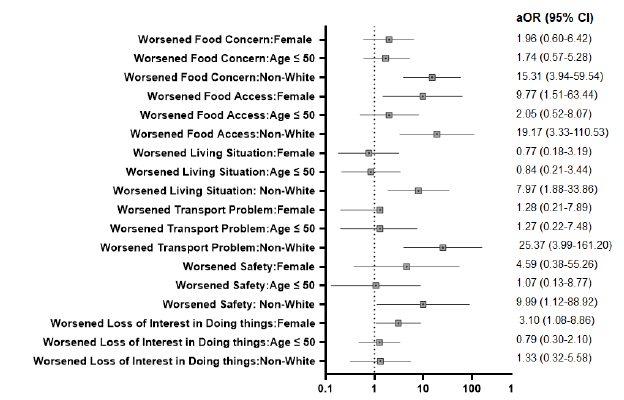
Figure. Odds Ratios of Additional Analysis aOR, adjusted odds ratio; CI, confidence